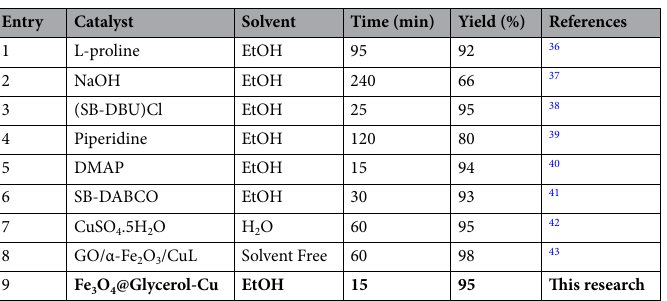
Table 3. The catalytic performance comparison of Fe 3 O 4 @Glycerol-Cu with past research. Significant values are in